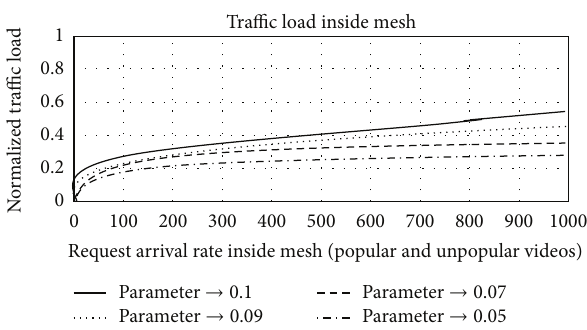
Figure 12: Normalized traffic load in interactive session (lower range of parameters).